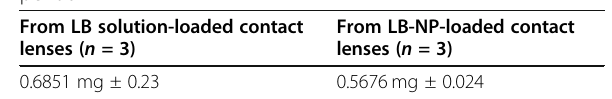
From LB-NP-loaded contact lenses ( n = 3)